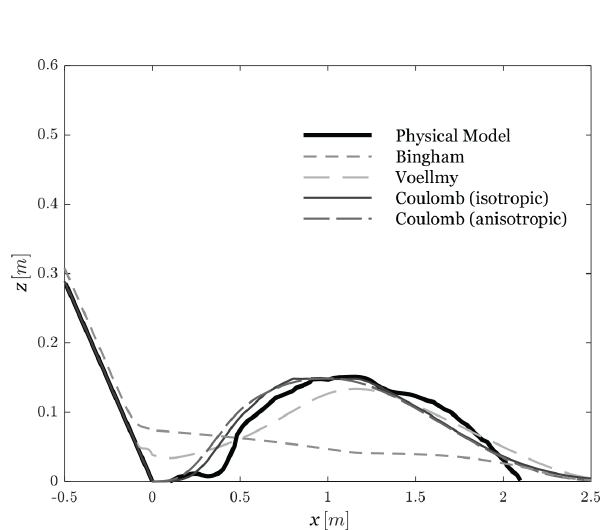
Figure 6. Cross section of the landslide deposit using different rhe- ological laws compared with the deposit in the physical